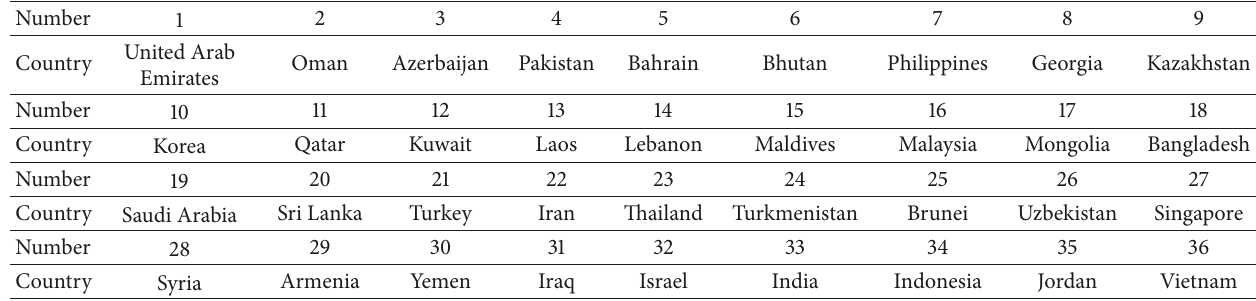
Table 2: Number 36 countries in Asia.